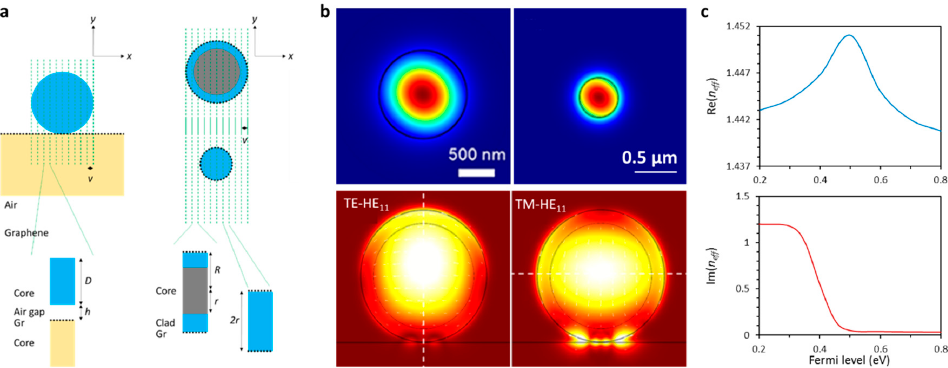
Figure 2. Calculation and simulation of graphene-based microfibers. ( a ) Scheme of the finite element method (FEM) simulation for graphene-based microfibers. ( b ) Simulated electric field intensity distributions. ( c ) Calculated effective index of a graphene-based microfiber, relying on the Fermi level of graphene. Here simulations in ( b ) are reproduced from Refs. [43,46].